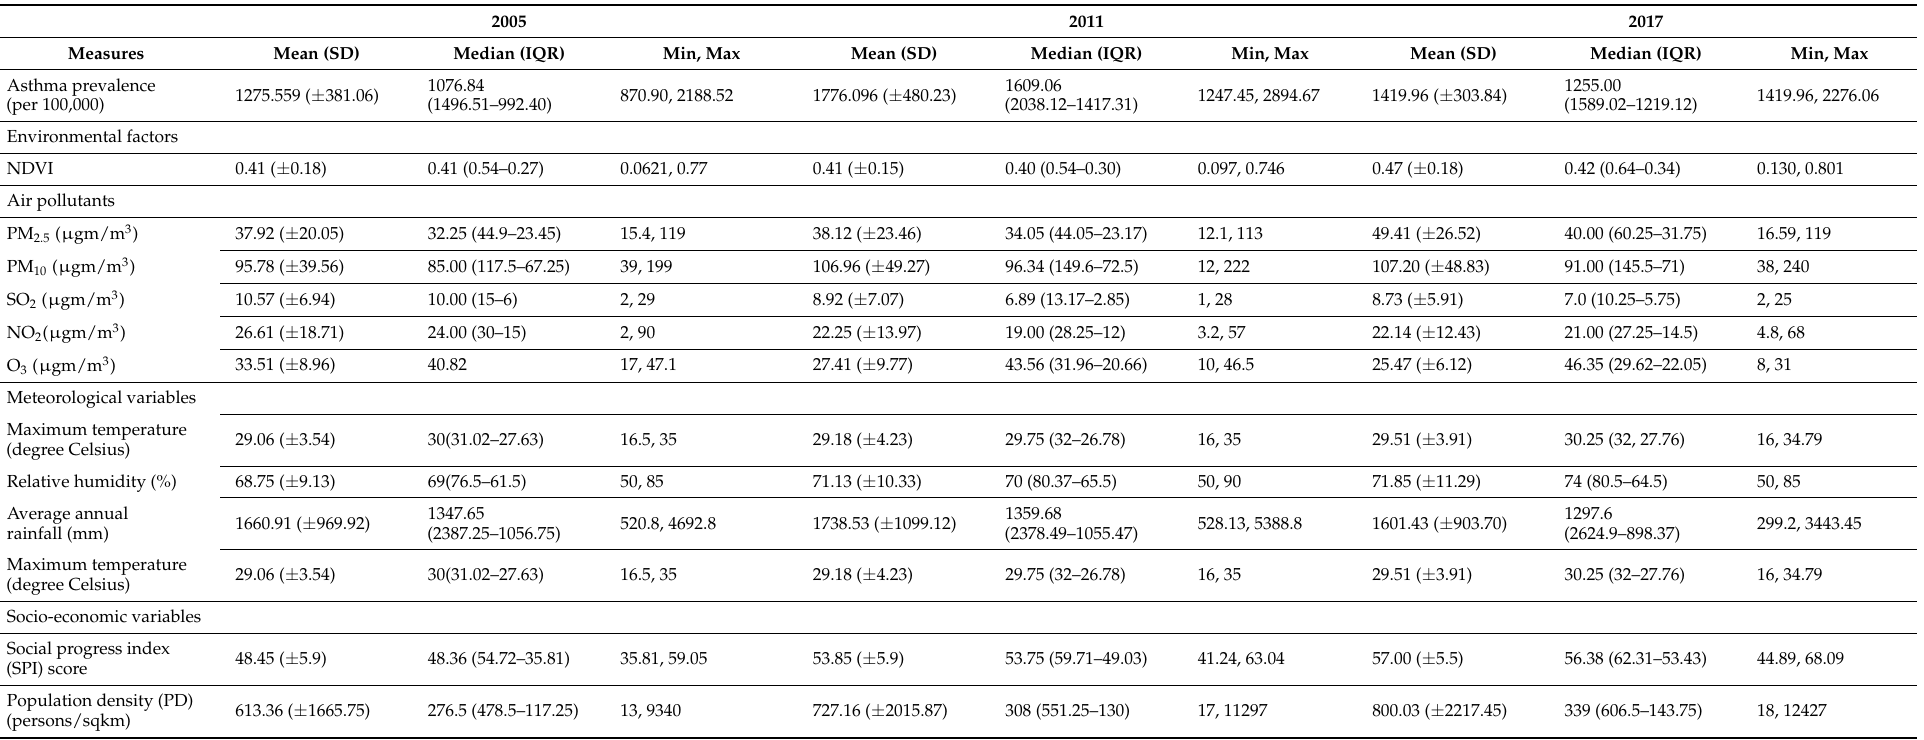
Table 1. Summary statistics for the asthma prevalence, environmental factors, and other socio-demographic factors for the years 2005, 2011, and 2017 in states of